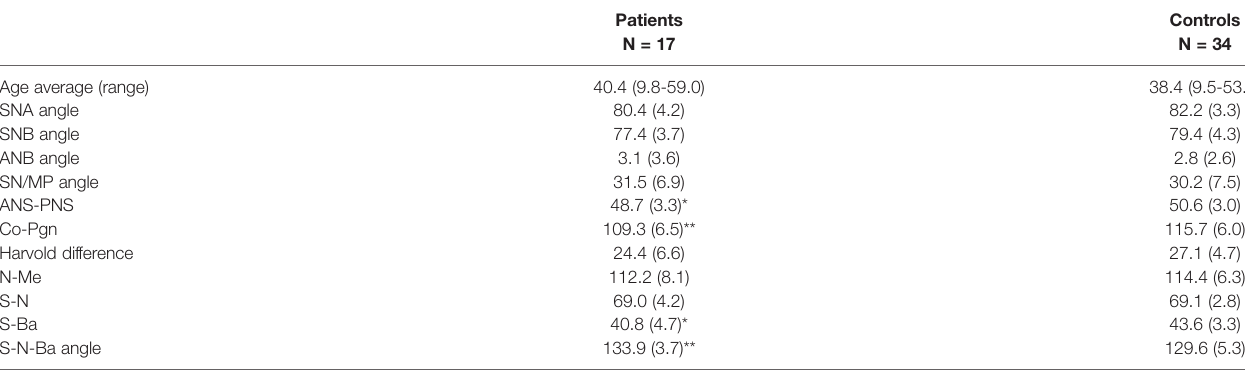
TABLE 1 | Cephalometric measurement average (and standard deviation) for patients and healthy